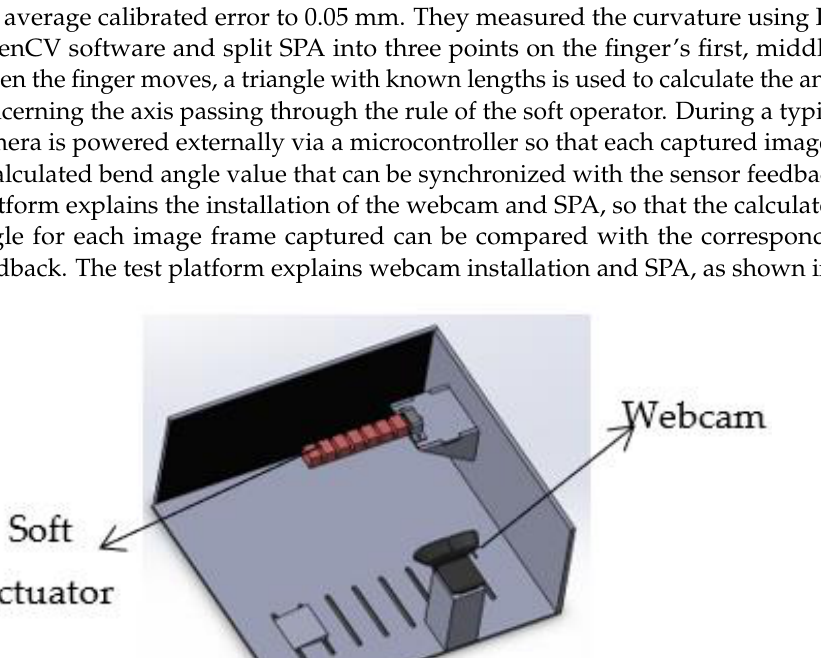
Figure 8. Impact of varies pressure on the output force for actuator. 2.3.4. Pressure Sensor The third sensory reaction that raises interest in this work is the difference in pressure at each of the two openings of the pressure sensor (MPX10DP). Since the change in pres- sure has been noticed to lead to a change in angle and force resulting from SPA, it is nec- essary to monitor the pressure to maintain the pressure inside the system and avoid any disturbances from the source.